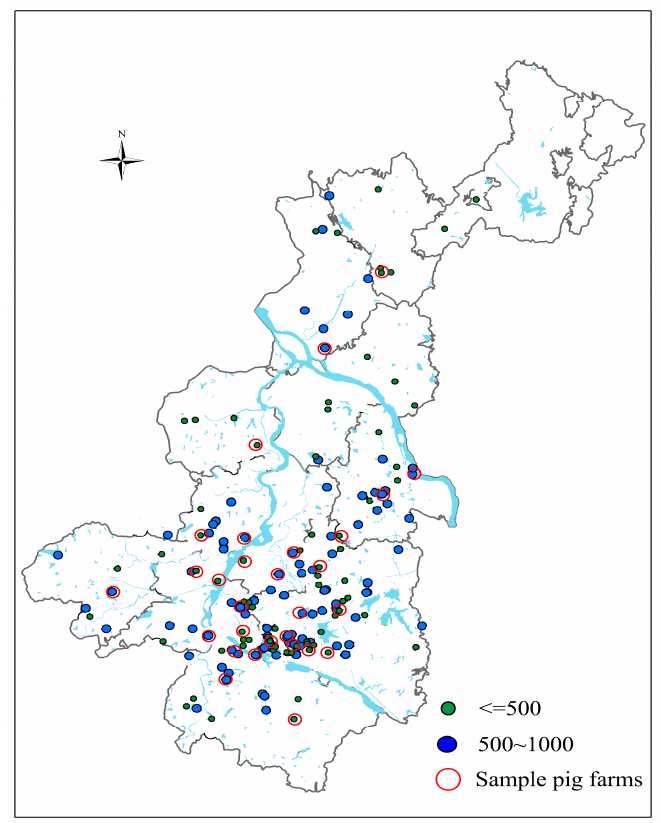
Figure 1. Distribution of small-scale pig farms ( ≤ 500 and 500–1000 heads in annual sold hog) and sample pig farms surveyed in Yujiang County, Jiangxi Province, China.